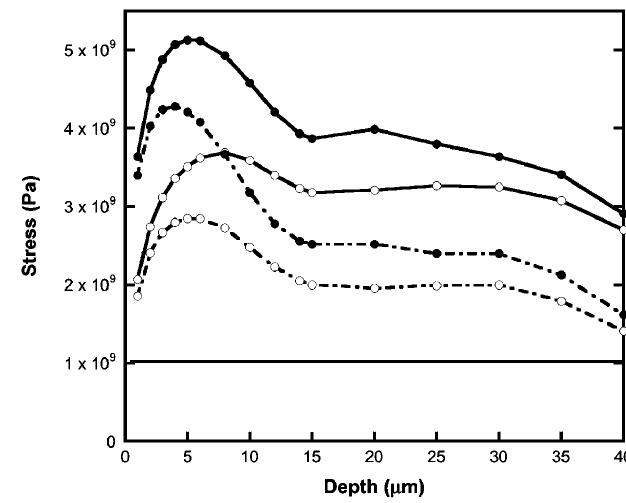
FIG. 8. Stresses at the bottom of the round-bottomed crack with and without sidewall heating, compared with plane surface stress with pulse duration 0 : 21 (cid:1) s , heat flux q ¼ 2 : 7 (cid:3) 10 10 W = m 2 . Similar to Fig. 7, solid curves represent the case with sidewall heating with the closed symbol for the maximum stress at the crack bottom and the open symbol for the average stress over the crack bottom. The two dashed curves denote the no sidewall heating